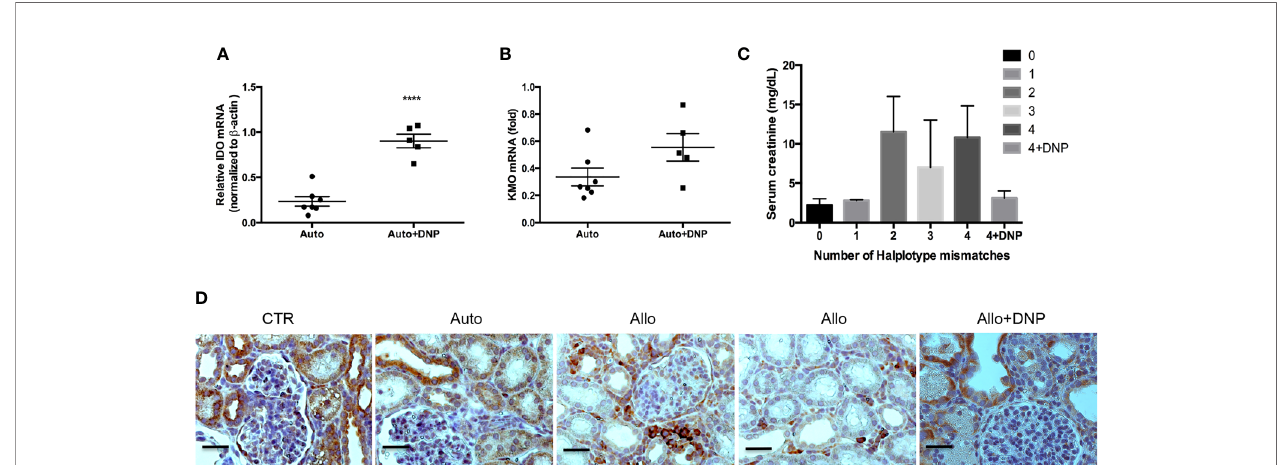
FIGURE 9 | Reduction of allograft rejection by DNP-induced KMO upregulation. Grafts were ex vivo perfused with DNP, transplanted, and harvested at 72hours post-transplantation. (A) DNP-induced IDO expression (B) DNP-induced KMO expression, (C) Effect of DNP treatment on renal function (serum creatinine) from mismatched transplants. (D) Representative KMO IHC expression from normal graft right kidney as control (CTR), and autograft (Auto), mismatched allograft (Allo), and mismatched allograft treated with DNP (Allo+DNP). **** p < 0.0001, analysis is multiple unpaired t-tests. The scale bar is